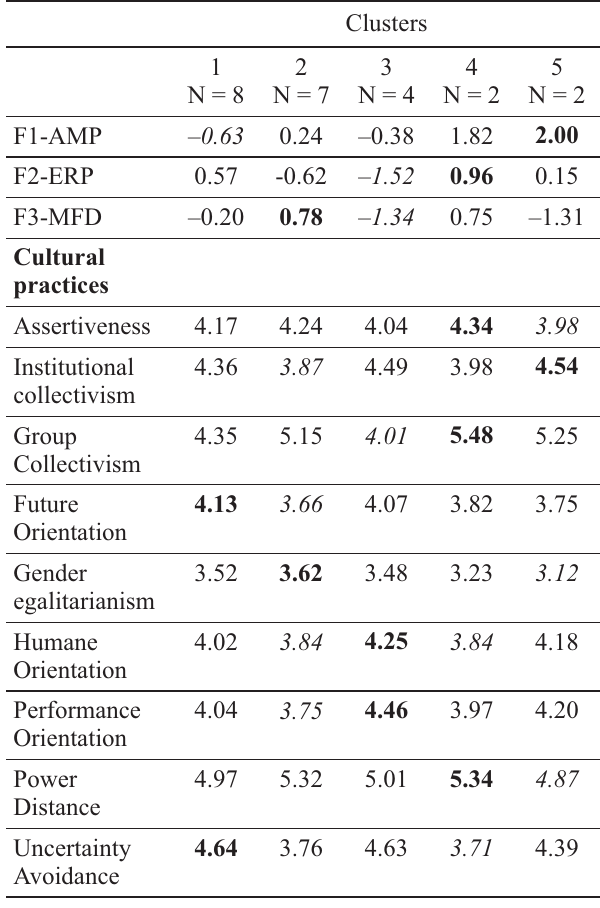
Table 4. Final Cluster Centers and means for